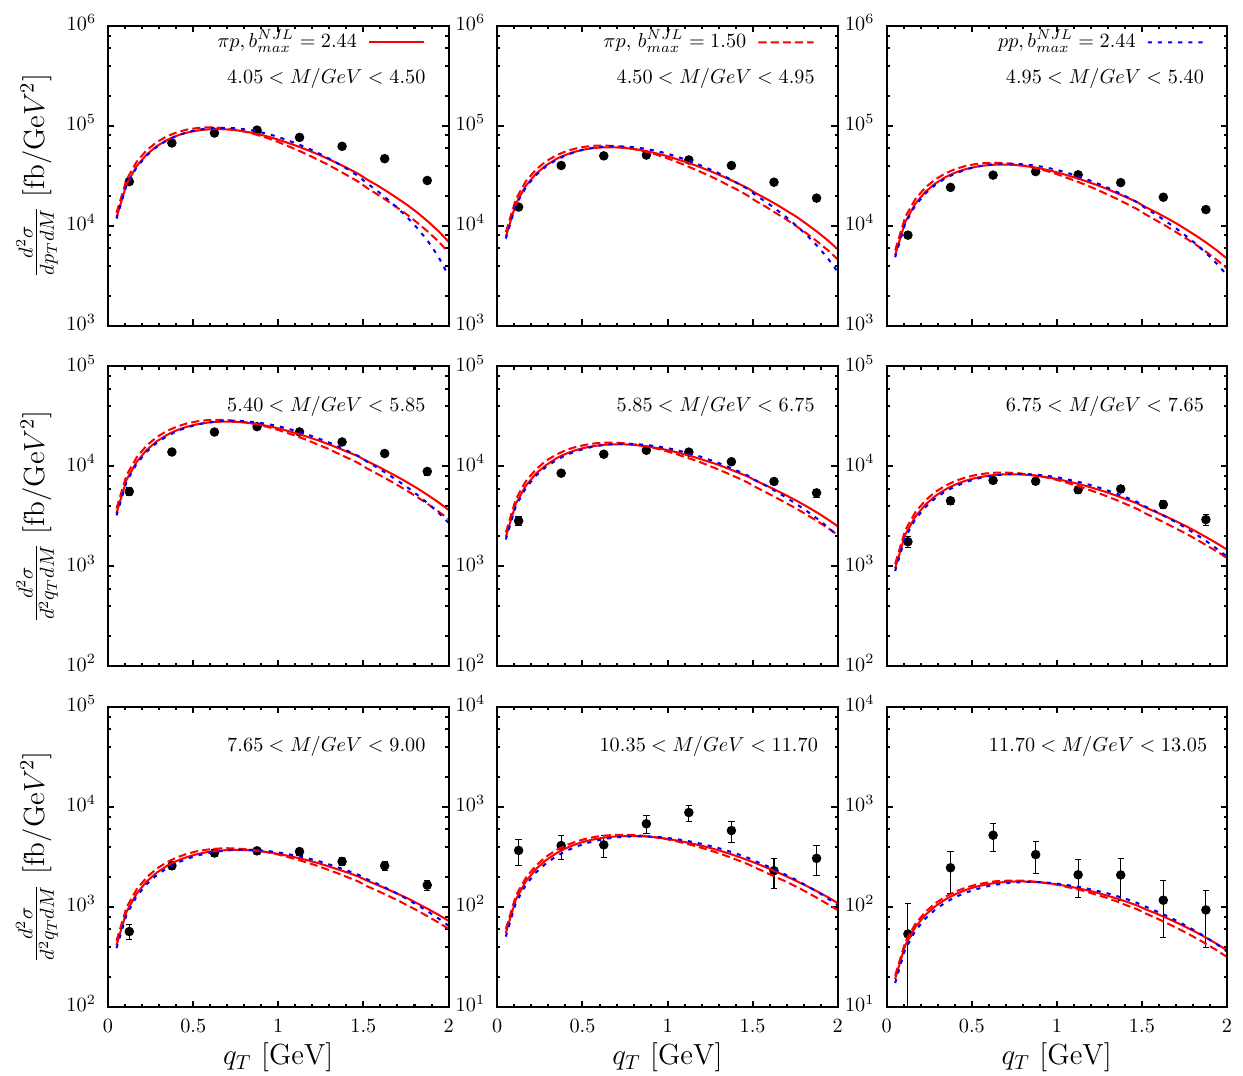
Fig. 4 Predictions compared to cross sections in various invariant mass bins of the pair integrated in 0 < x F < 1. Data from Refs.